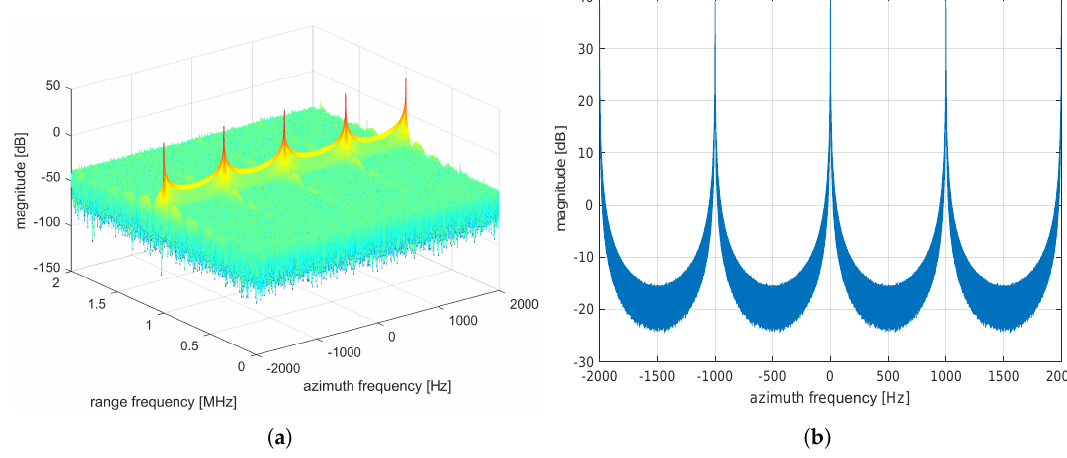
Figure 13. Azimuth spectrum before MCRA: ( a ) three-dimensional plot; ( b ) two-dimensional plot at target. MCRA: multi-channel reconstruction